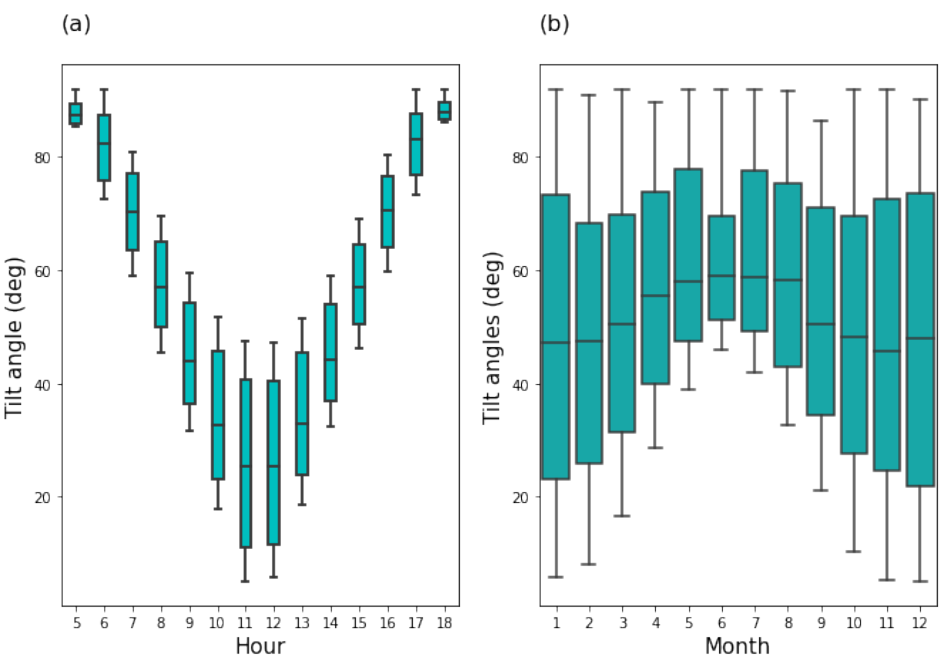
Figure 8. Tilt angles visualised ( a ) hourly and ( b ) monthly for three years.